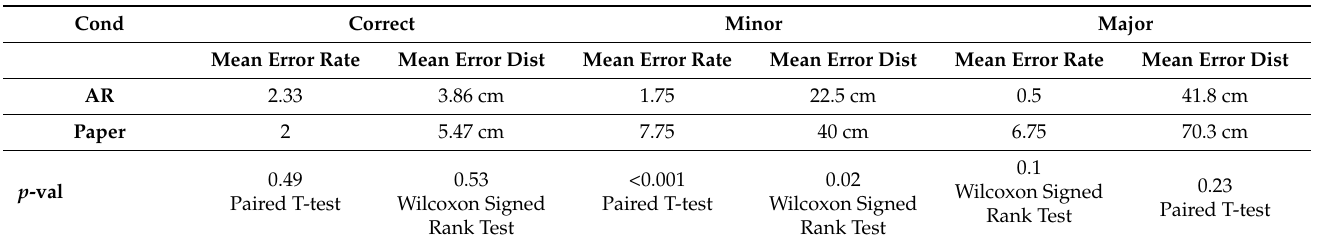
Figure 14. Participant approximations of the distances between virtual and physical elements. Table 4. Summary of common errors made by participants using AR and paper-based